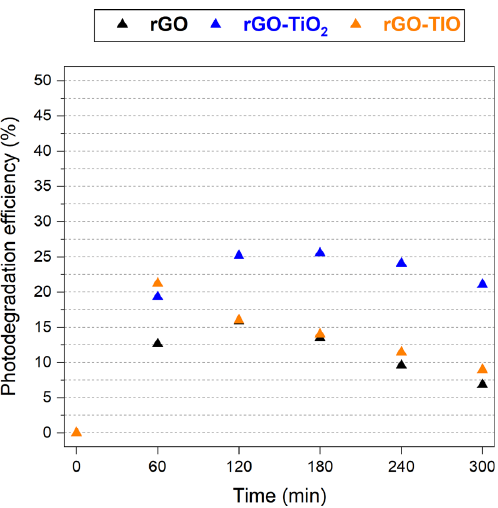
Figure 10. Photodegradation efficiency of rGO, rGO–TiO 2 , and rGO–TIO membranes as a function of irradiation time.